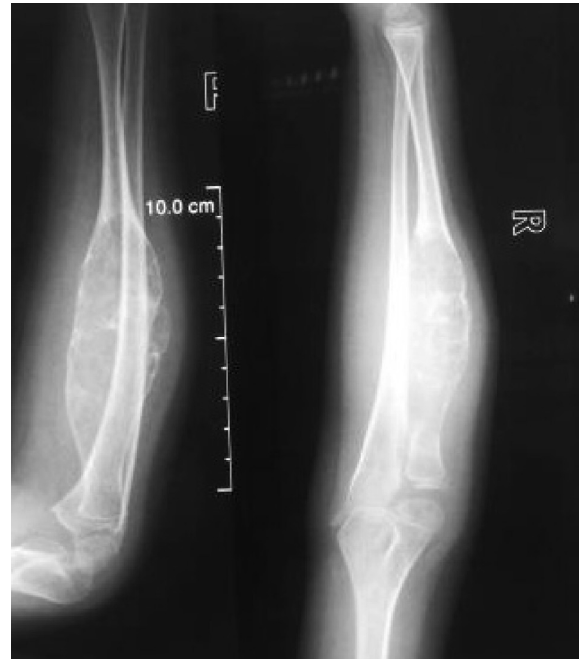
Figure 2. Anteroposterior and lateral views suggesting that the lesion had increased in its size with thinning out of cortex.